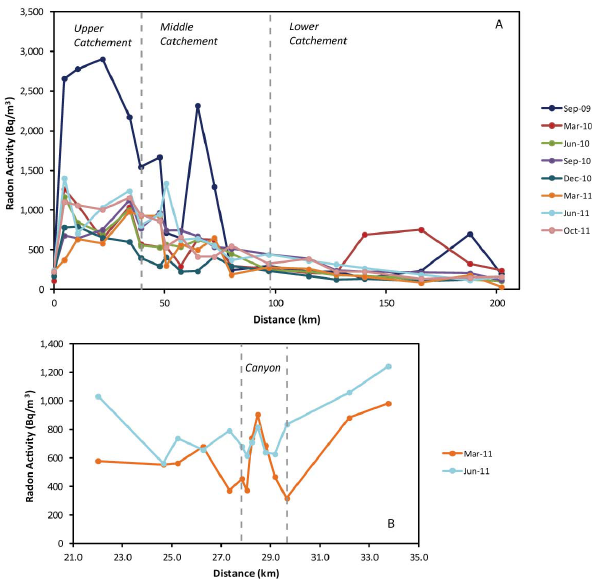
Fig. 6. (A) Variation of 222 Rn activities in the river (Table 4). High 222 Rn activities are recorded in the upper catchment and decrease down the valley. Temporal variation in the 222 Rn activities is mini- mal in the lower catchment. (B) 222 Rn activities along the Bright– Porepunkah reach in March and June 2011. Distinct 222 Rn peaks at 28.5km (at which higher EC values are also found (Fig. 4b), followed by a gradual increase in 222 Rn activity in both sampling rounds.